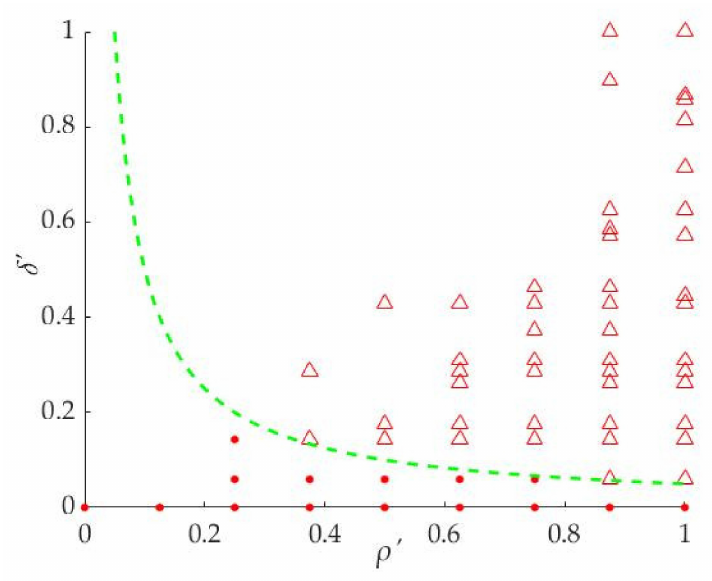
Figure 6. Extracting the cluster centers by inverse function. The triangle symbols are the center points and the red dots are the other points.